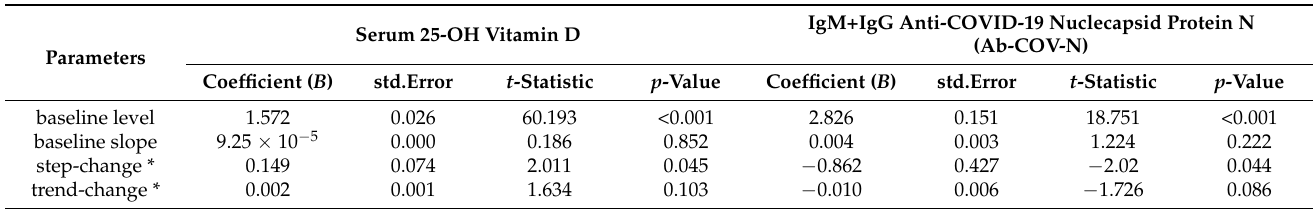
Table 1. Segmented regression analysis with single changepoint (transformed